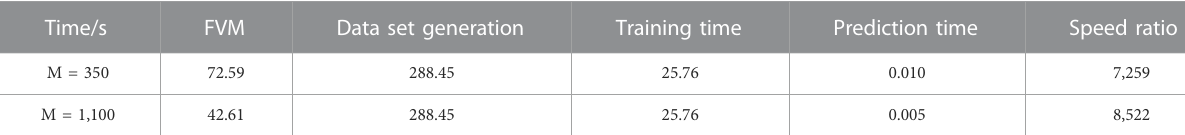
TABLE 3 Computational cost comparison in case